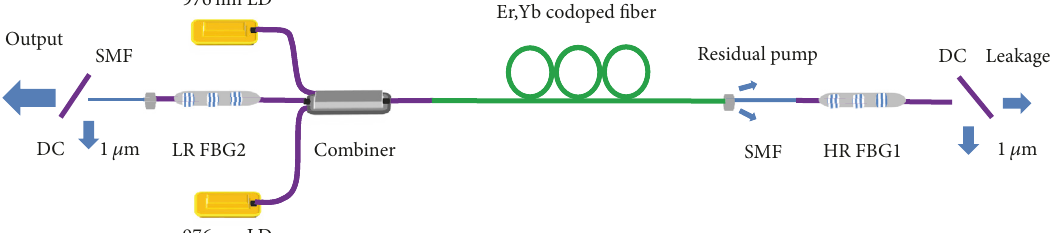
Figure 1: Experimental schematic of the single-mode all-fiber Er,Yb codoped laser. DC: dichroic mirror; SMF: standard single-mode fiber; FBG: fiber Bragg